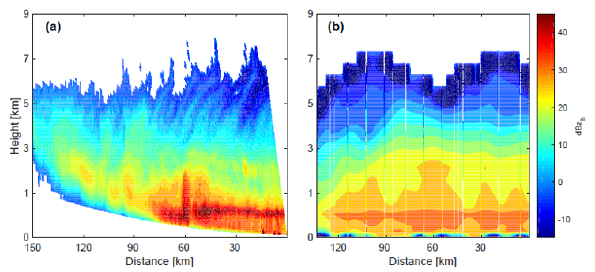
Figure 4. Model-measurement intercomparison of range-height in- dicator scans of radar reflectivity Z DH along the 255 ◦ radial out from CFARR. CAMRa Doppler radar measurements are shown in panel (a) for the scan taken between 19:22:07 and 19:23:07UTC, and modeled values are shown from the CTRL simulation at 19:00:00UTC, both in dBZ h